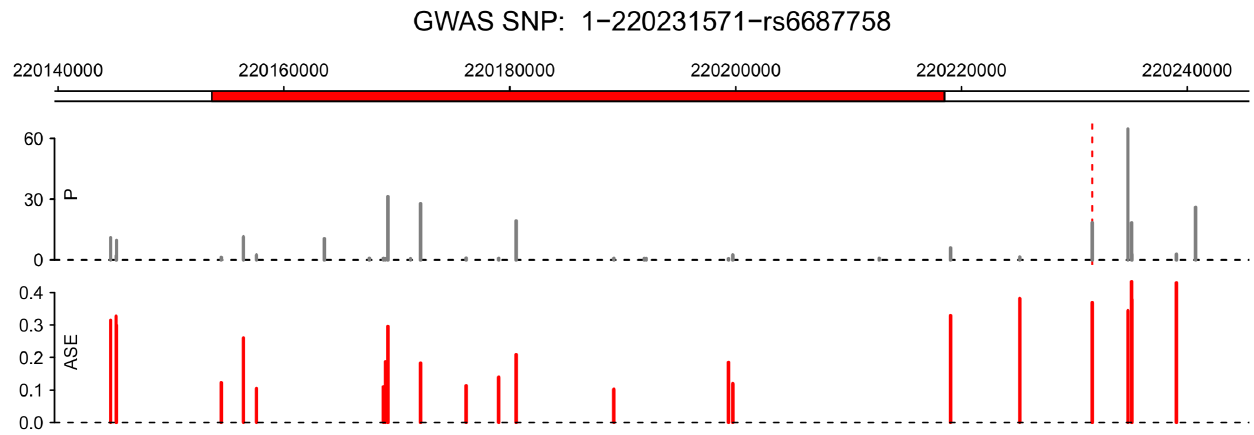
Figure 3. Illustration of a region with a SNP from genome wide association studies (GWAS) which is associated with ASE of lncRNAs. The tracks are from top to bottom in each panel: Horizontal red bars represent lncRNA transcript windows (with genomic coordinates) used for determination of ASE levels; grey lines show p-values for the association of GWAS SNPs with ASE levels in the transcript window; a grey line overlayed with a red dotted line indicates that a cis -rSNP overlaps with the reported SNP in the GWAS catalog; red vertical lines are median ASE-levels for each SNP.